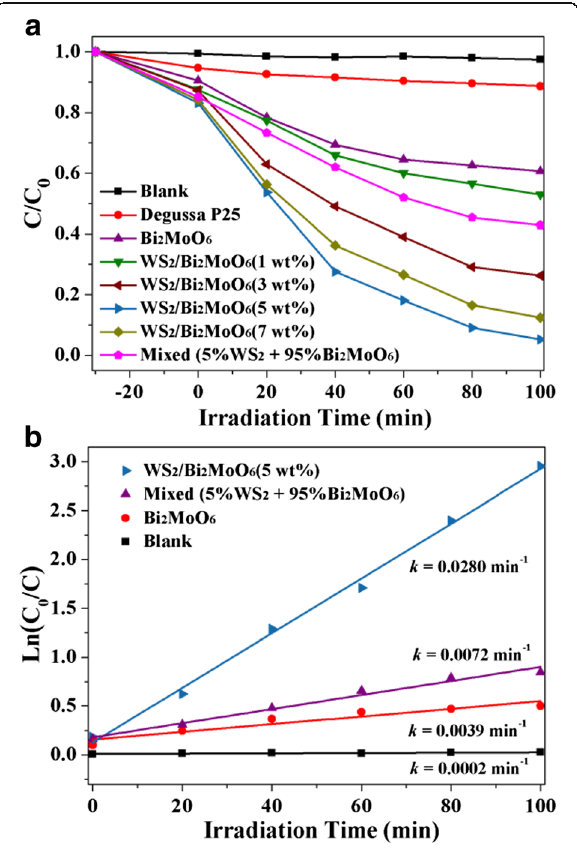
Fig. 6 The photocatalytic activity ( a ) and kinetic fit ( b ) of the different photocatalysts for RhB